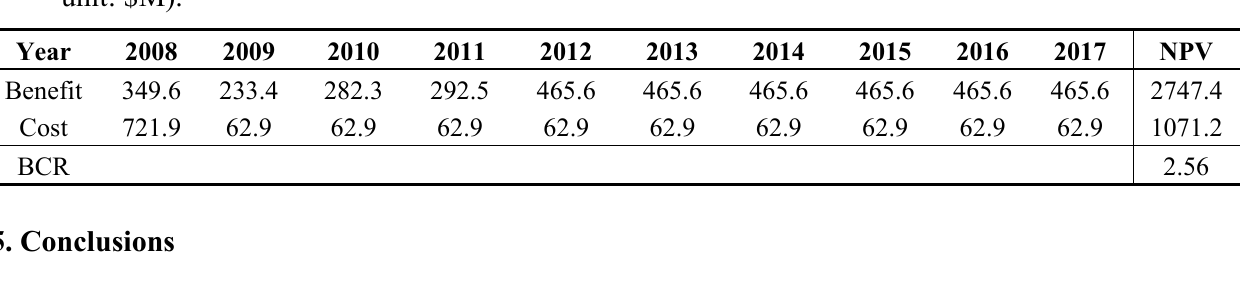
Table 3. Benefit–cost ratio of ESS investment (discount rate: 6.5%/year, 500 MW ESS, unit: